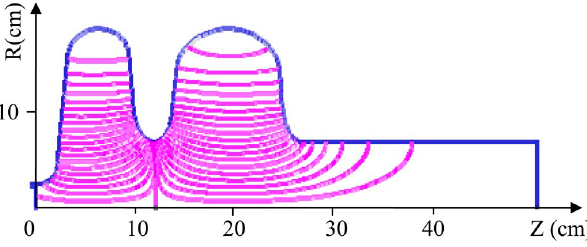
FIG. 13. 1 1 cell rf gun cavity, calculated with SUPERFISH 2